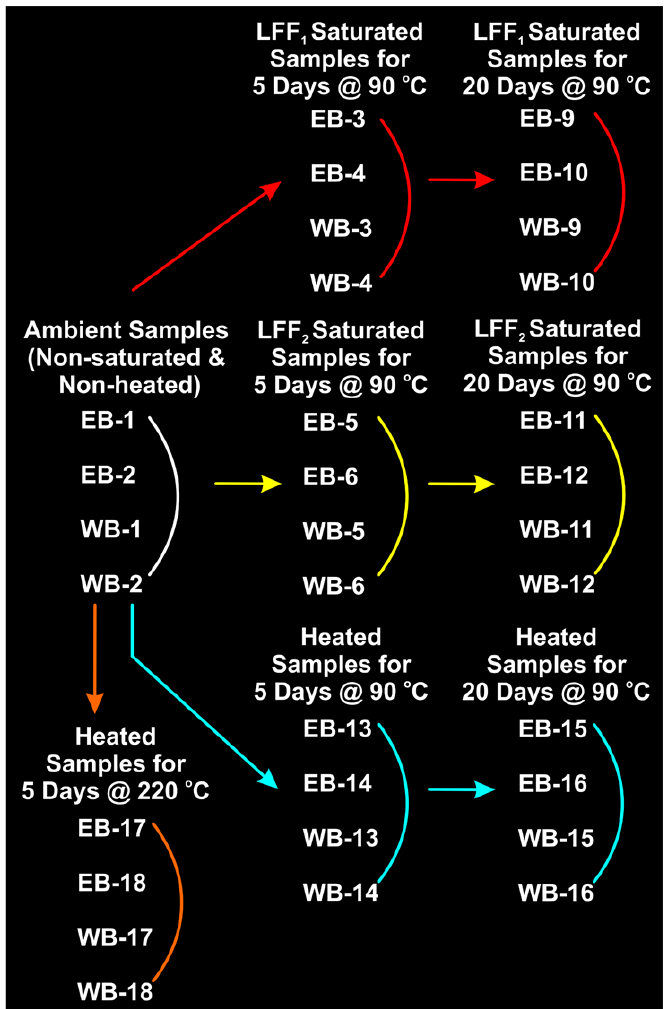
Figure 4. Brazilian disc-shaped samples of Eagle Ford (EB) and Wolfcamp (WB) shales with indica- tions of associated treatment conditions. Samples EB-7, EB-8, WB-7, and WB-8 were damaged upon handling and were excluded from this research.